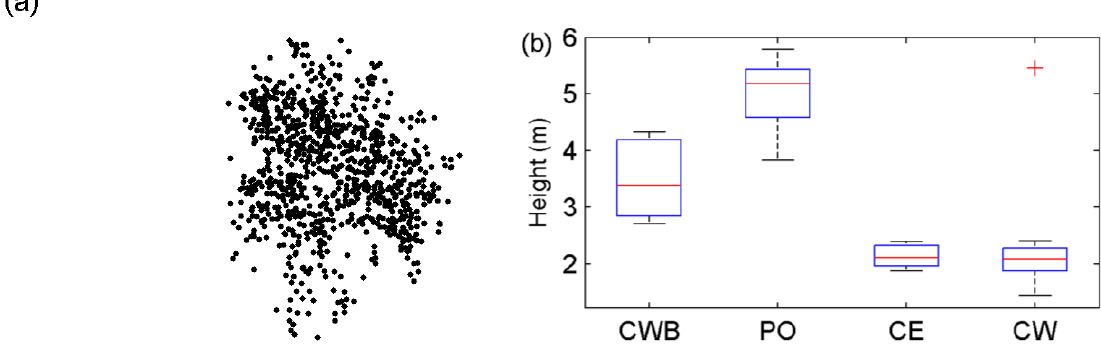
Figure 2. Illustration of the represented trees based on the laser scanning data ( a ) and the statistics of the heights of the target trees individually for the four tree species ( b